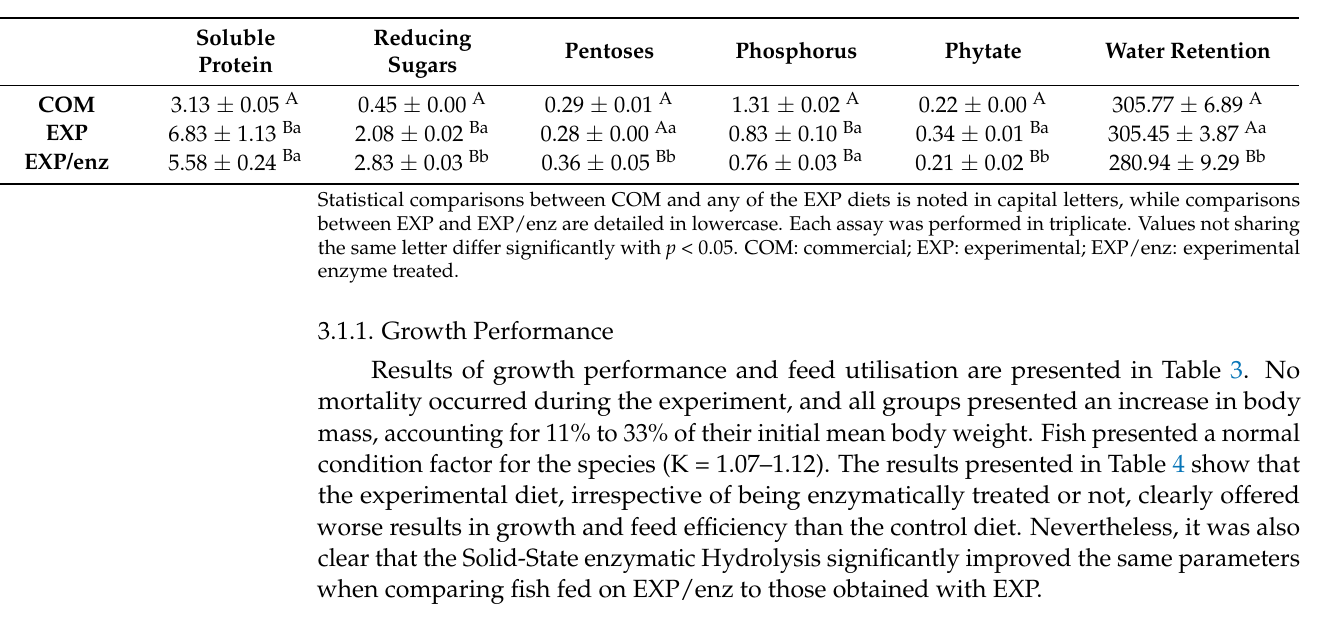
Table 3. Growth and feed efficiency measured in fish fed on the experimental diets.